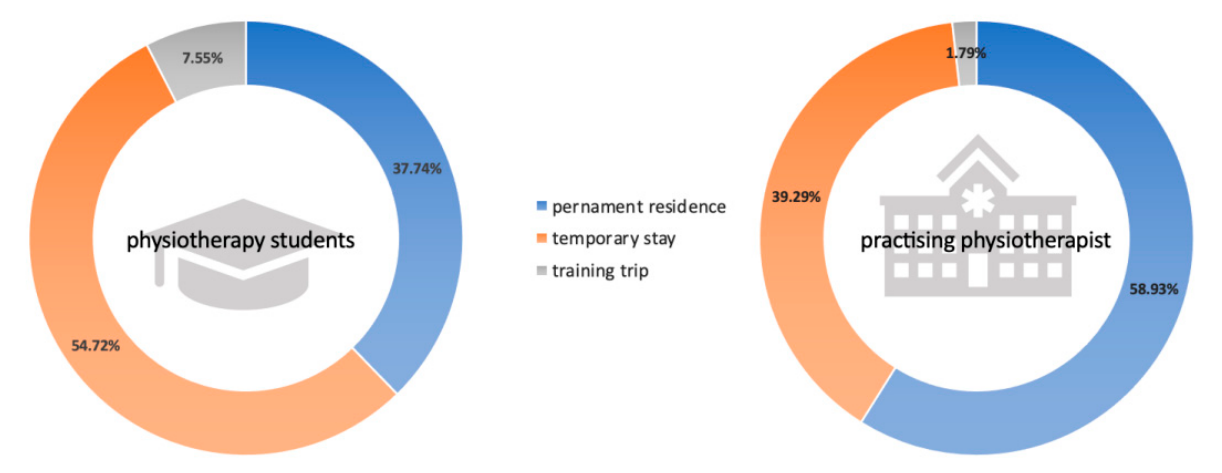
Figure 1. Comparison of the purpose of migration of physiotherapy students and practicing physiotherapists.